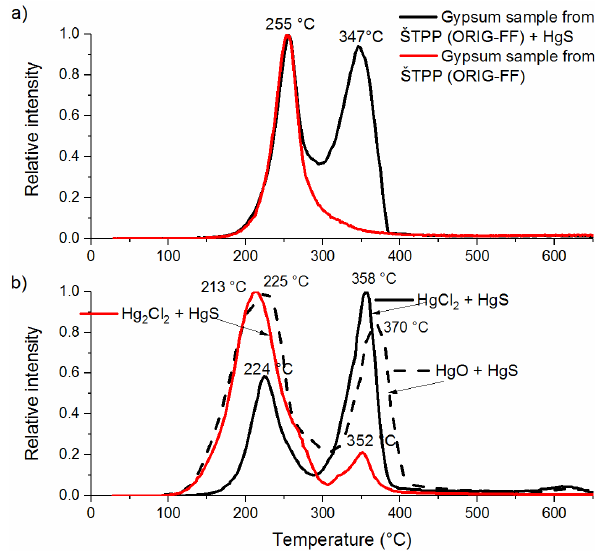
Figure 9: TPD spectra of precipitate of HgCl of CaSO ·2H O and FeOOH without the addition NaCl and with two 4 2 different concentrations of NaCl (0.006 and 0.17 M).